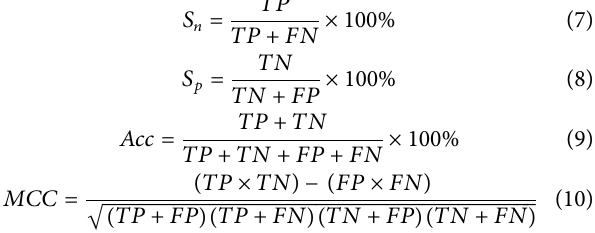
Frontiers in Genetics |